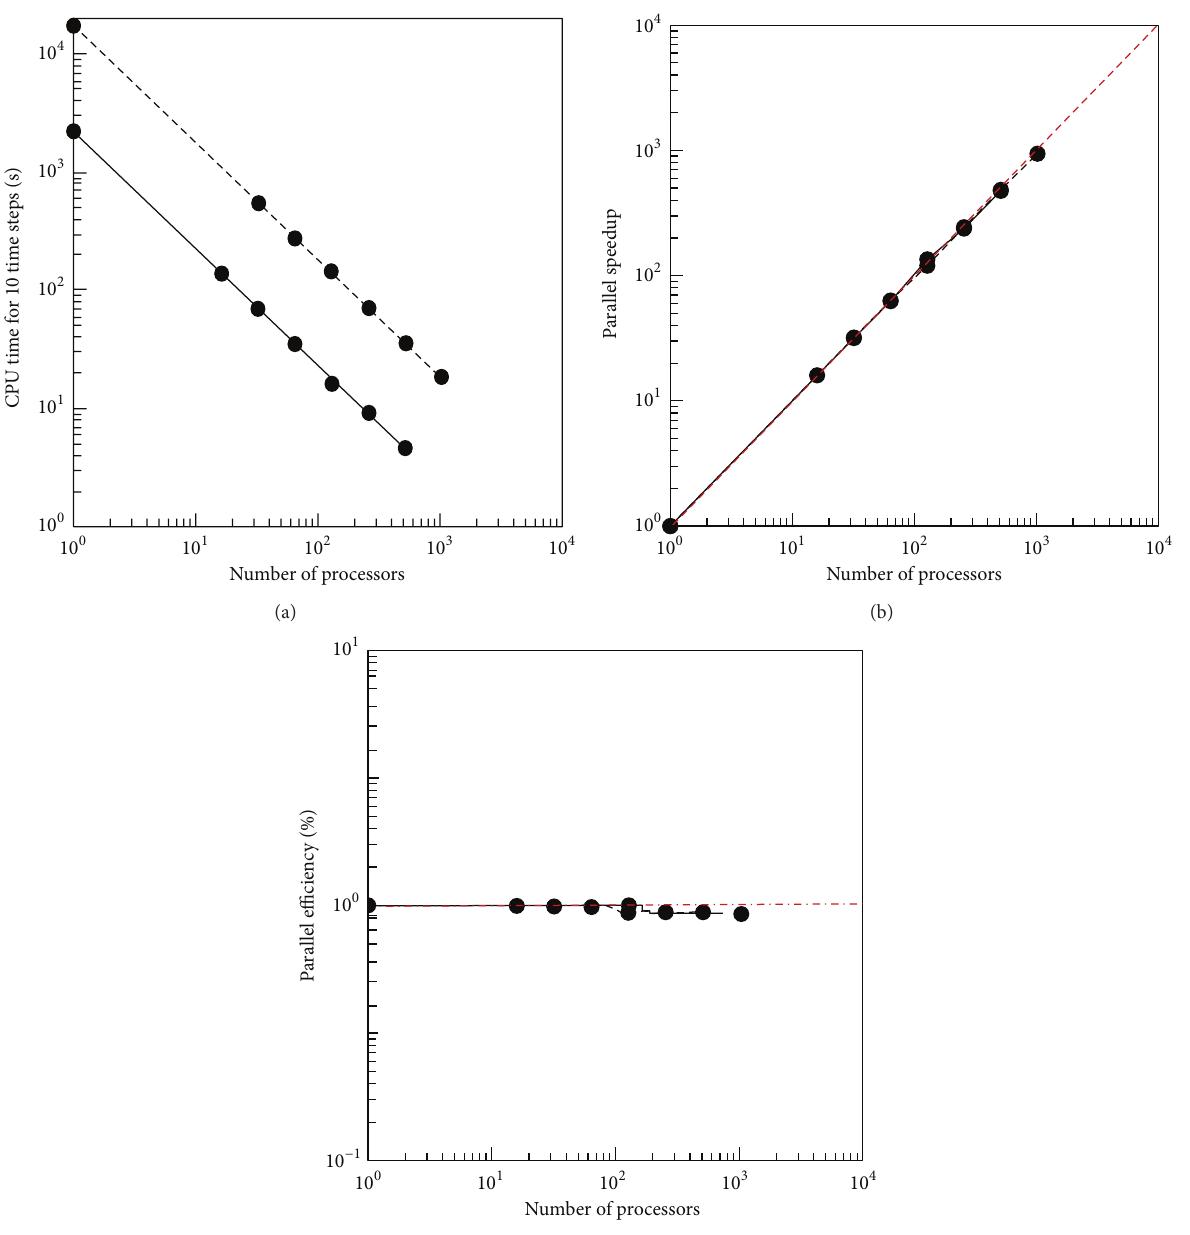
Figure 7: Parallel scaling analysis for the solution of the Euler hydrodynamics system (21) on two different problem sizes: (a) CPU time for 10 time steps, (b) speedup, and (c) efficiency; solid line with symbols: 128 3 ; dashed line with symbols: 256 3 . The red dashed line indicates perfect or ideal